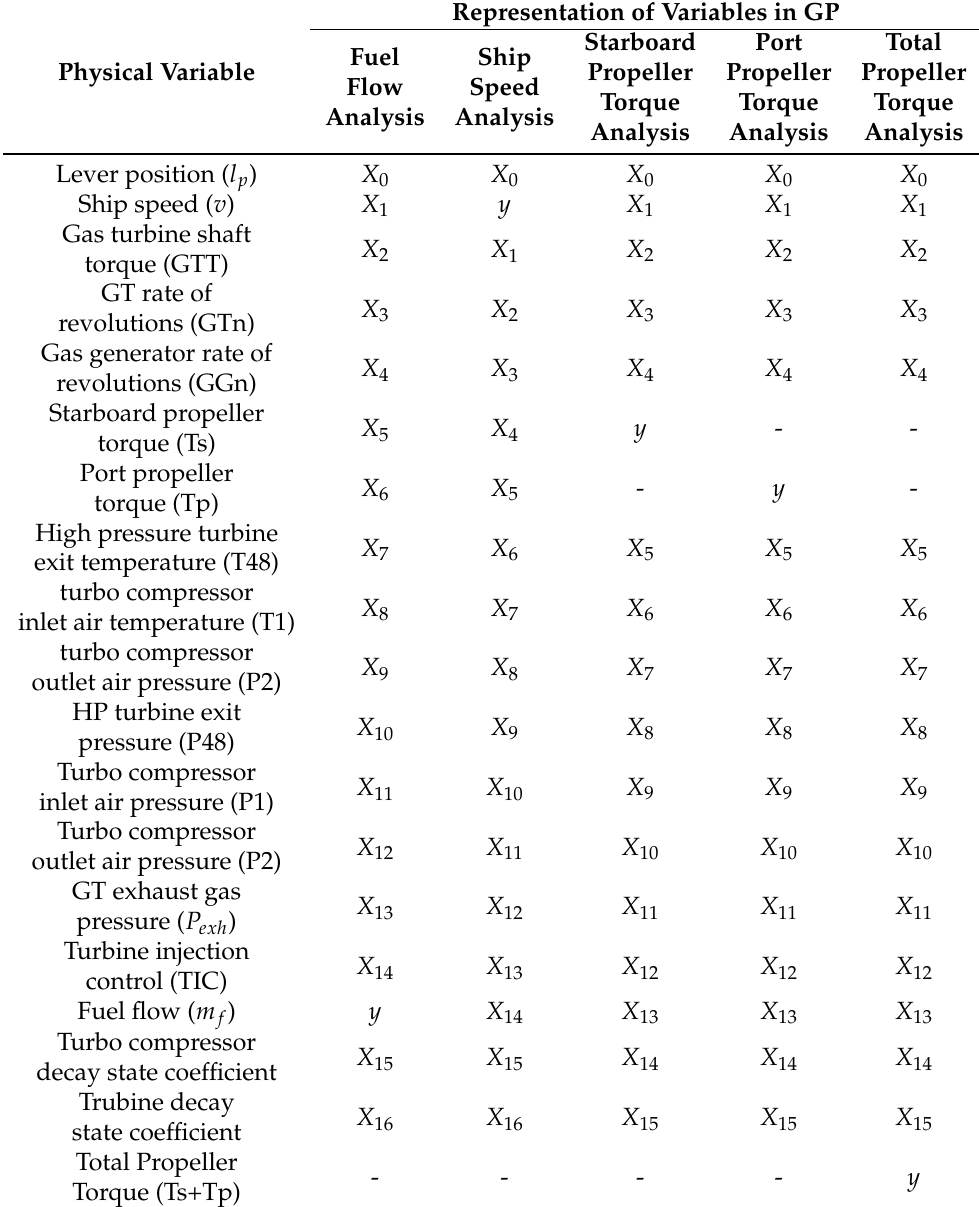
Table 2. The input and output variables used in the GP algorithm to obtain symbolic expressions for estimation of fuel flow, ship speed, starboard, port, and total propeller torque with and without decay